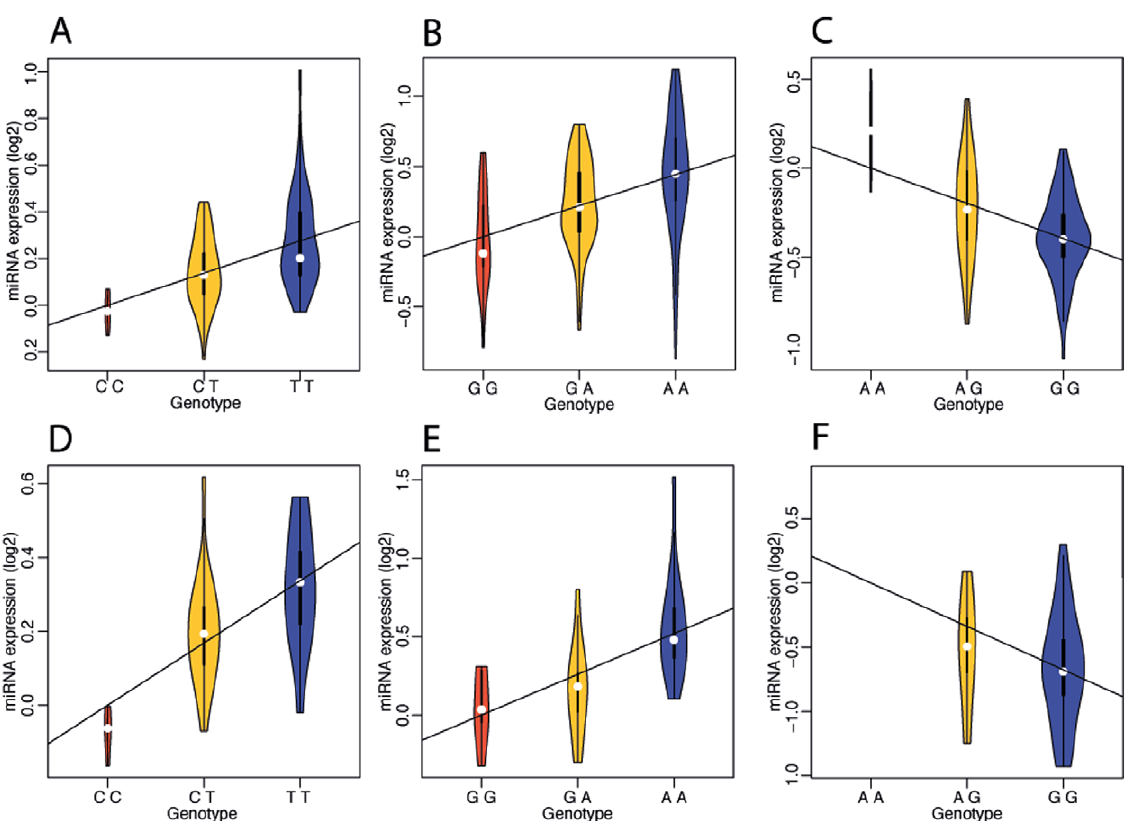
Figure 4. Genetic effects in replicated miRNA eQTLs in gluteal adipose tissue (see Materials and Methods section for criteria). The violin-plot represents the density of miRNA expression relating to the SNP effect for each genotype (variability relating to other fixed effects was regressed out); the line represents the fixed-effect coefficient ( b ) relating to the SNP effect. A) Primary study hsa-miR-1255a :rs1822168 B) Primary study hsa-miR-1307 :rs11191666. C) Primary study hsa-miR-330-3p :rs7252175 D) Replication study hsa-miR-1255a :rs1822168. E) Follow up study hsa-